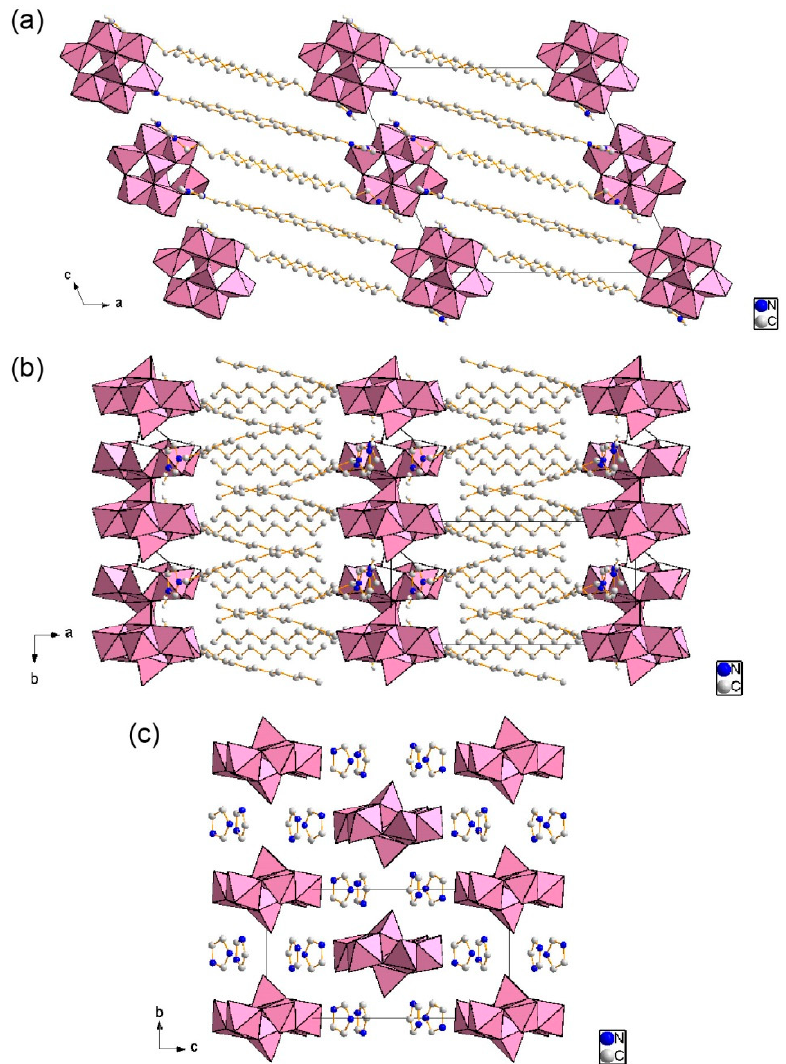
Figure 4. Crystal structure of 2 (C: gray, N: blue; δ -Mo 8 anions in polyhedral representations). H atoms are omitted for clarity; ( a ) Packing diagram along b axis; ( b ) Packing diagram along c axis; ( c ) Molecular arrangements in the inorganic layers. The dodecyl groups are omitted for clarity.